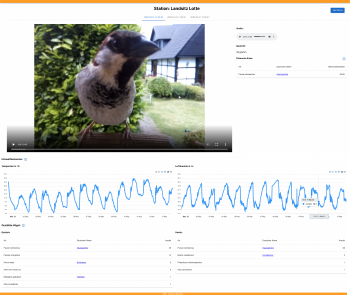
Figure 3. Website showing the station view including video, audio, detected species, trend of temperature and humidity, as well as a list of the visiting birds in the last two